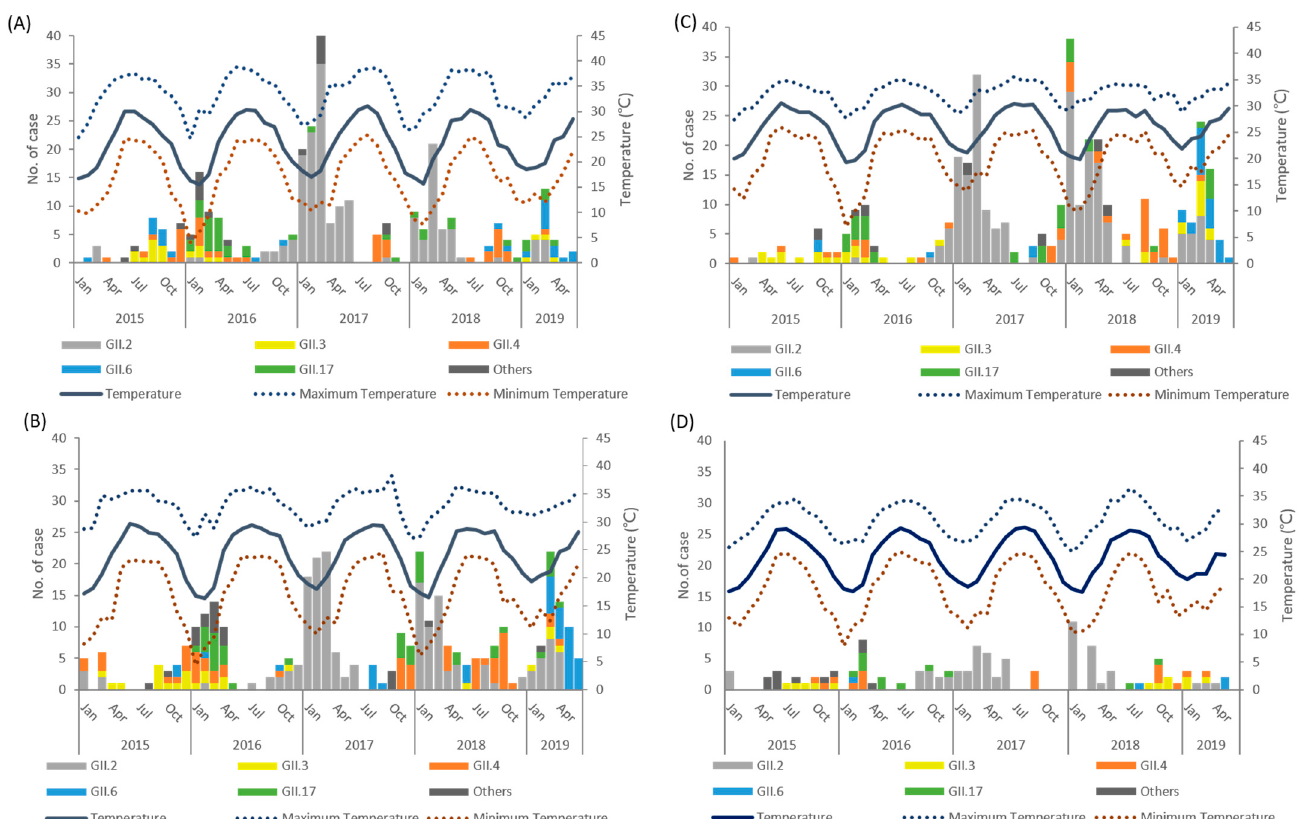
Figure 2. Trends of norovirus genogroup II infections over time and daily temperature in diverse regions of Taiwan, 2015–2019: ( A ) North region; ( B ) West region; ( C ) South region; ( D ) East region. In all regions, except the East region, data archived a level of statistical significance in simple linear regression analysis ( p < 0.05). Table 2. Relationship between norovirus and climatic factors in Taiwan, 2015–2019.